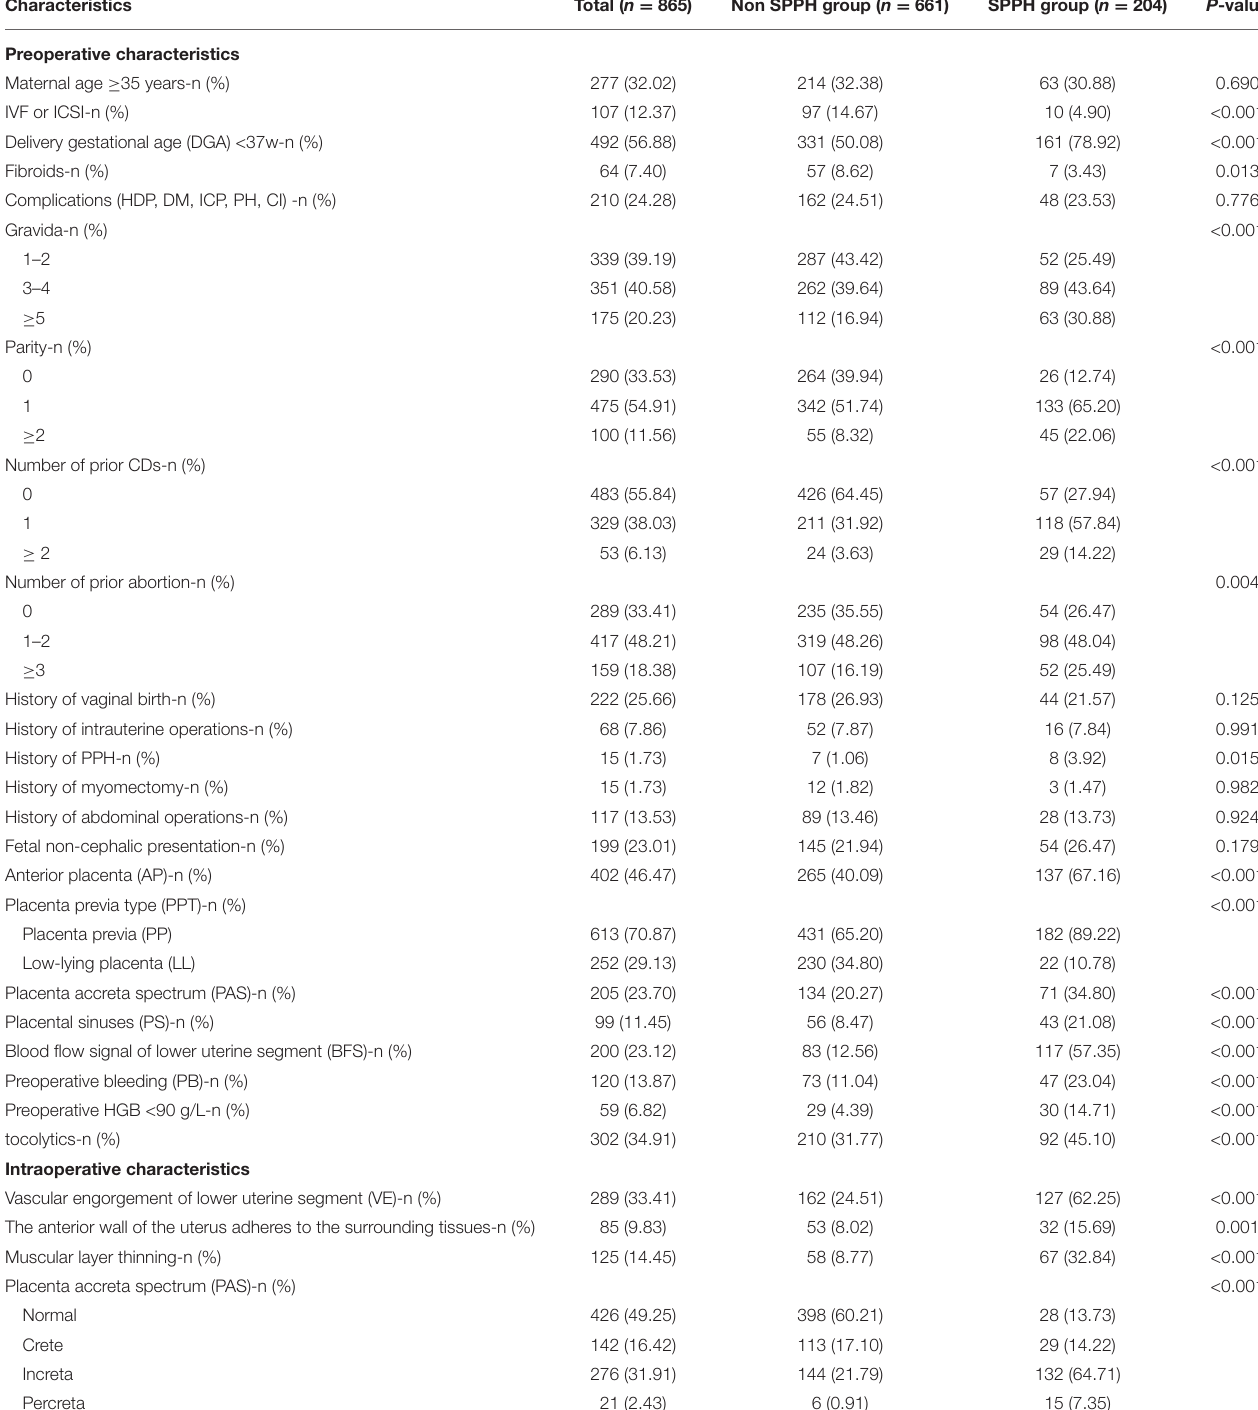
TABLE 2 | Univariate analysis in the development